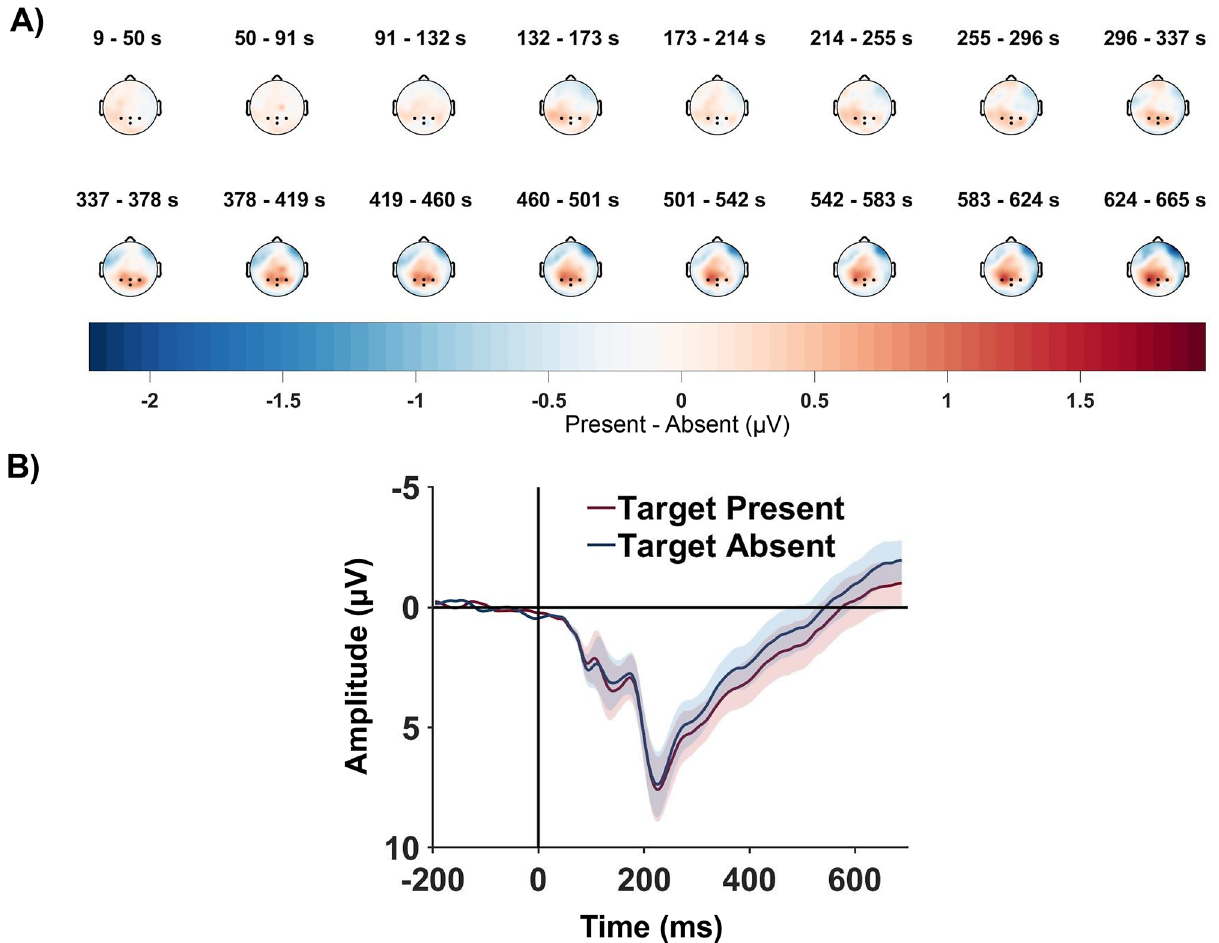
Figure 2. Univariate neural data analysis. ( A ) Topographic plot of Target Present—Target Absent difference wave. A dominant parietal activity is observed 300 ms onwards. The color-bar represents the magnitude of the difference wave in µ V . ( B ) ERP waveforms corresponding to Target Present and Target Absent trials. Mean taken across 4 electrodes—P3, Pz, P4 and POz. Shaded area indicate ± SEM. The position of the 4 electrodes are marked using black dots in the topoplots of ( A